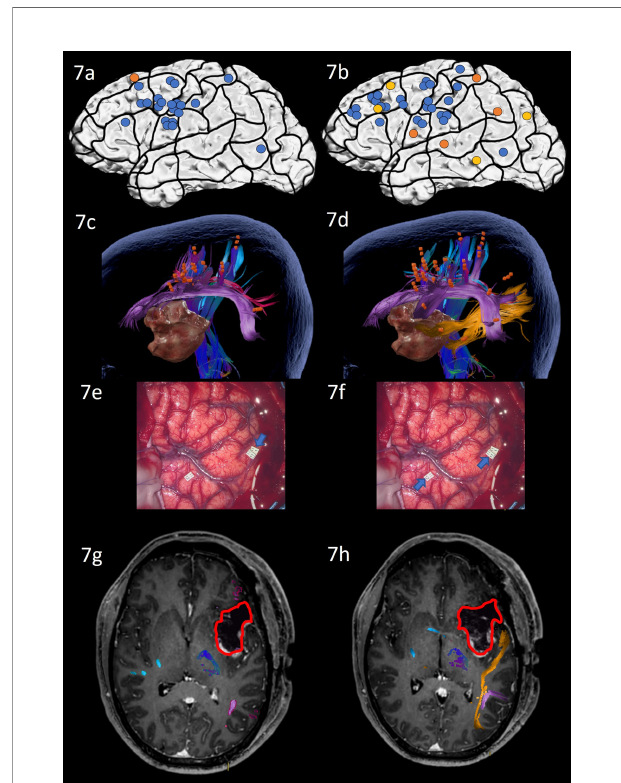
FIGURE 7 | Case 7. Left panels show ON results, right panels AN results. Panels (A, B) nTMS stimulation sites that induced errors; no response and hesitations in orange, semantic errors in yellow and performance errors in blue. Panels (C, D) Fiber tracking results including the lesion, nTMS cortical endpoints in orange and color-coded tracts with CNT in direction-coded, here dark blue, AF in purple, SLF in pink, ILF in yellow, and CF in light blue. Panels (E, F) Screenshot of intraoperative positive cortical sites with tag 1 PoG for ON, and tags 11 + 12 on PoG and the middle STG for AN. Panels (G, H) Overlap of tracking and postoperative T1-weighted imaging after elastic with the resection cavity marked in